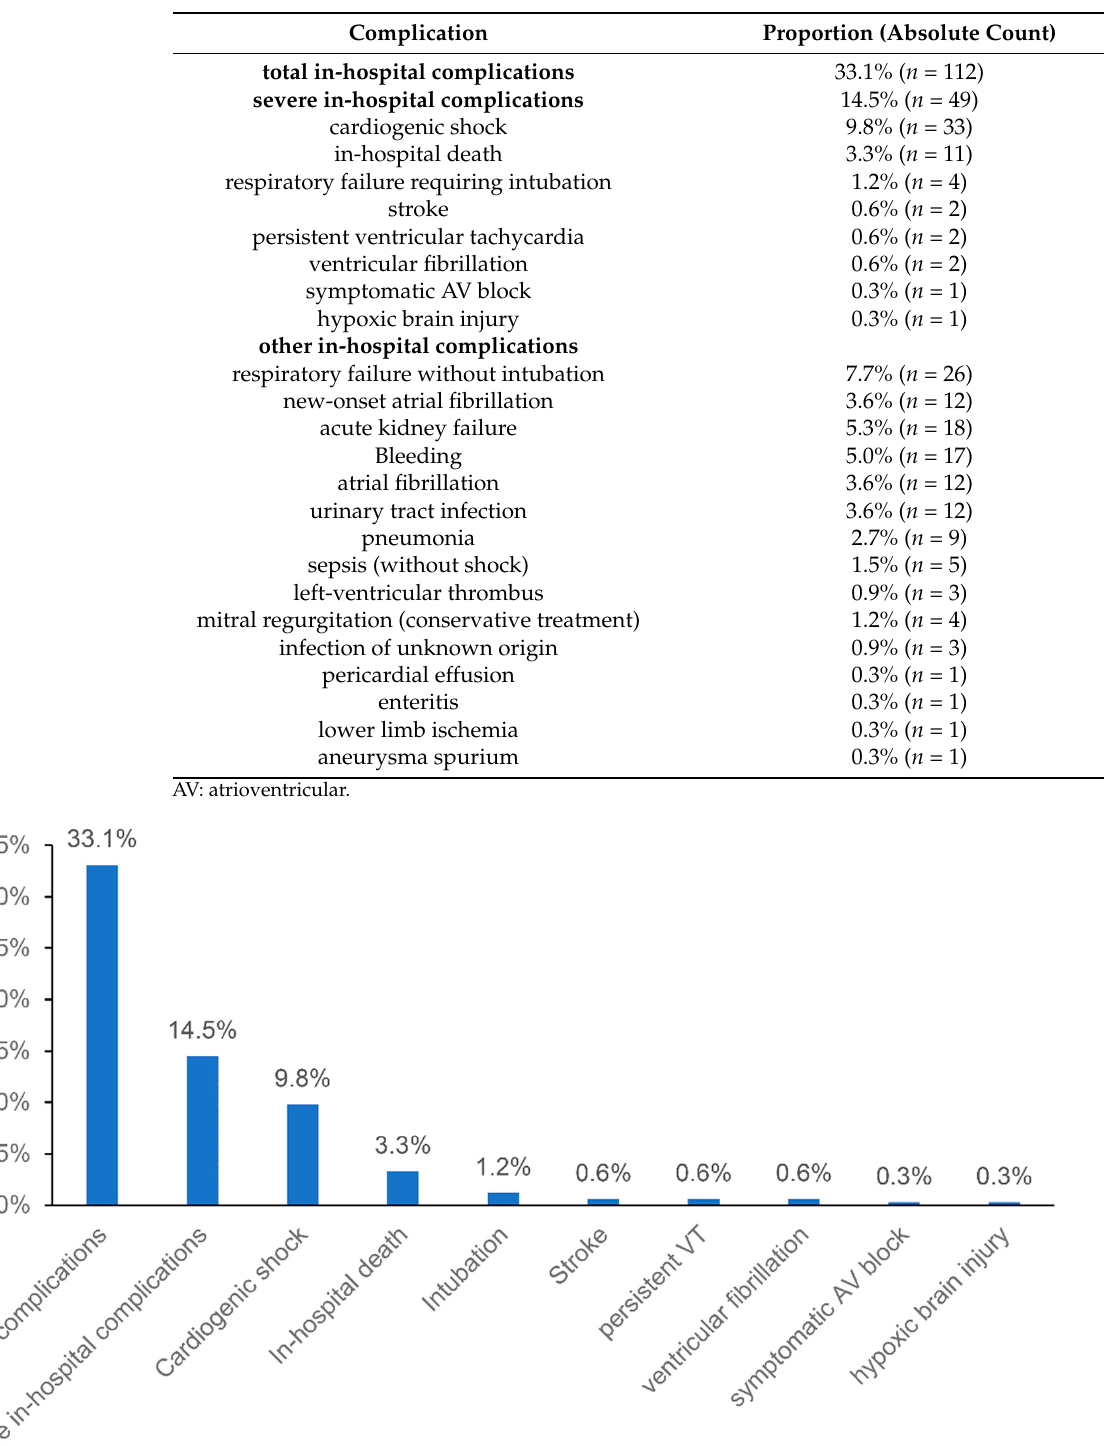
Table 2. Total, severe and other in-hospital complications in the whole study population.